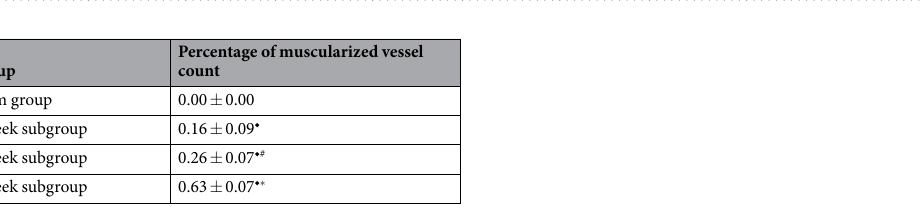
Table 1. The percentage of muscularized vessel count in the rat CTEPH model. Note: Data are expressed as (mean ± SD) %. ◆ P < 0.05, compared to the sham group; # P < 0.05, compared to the 1-week experimental subgroup; ∗ P < 0.05, compared to the 1- and 2-week experimental subgroups.